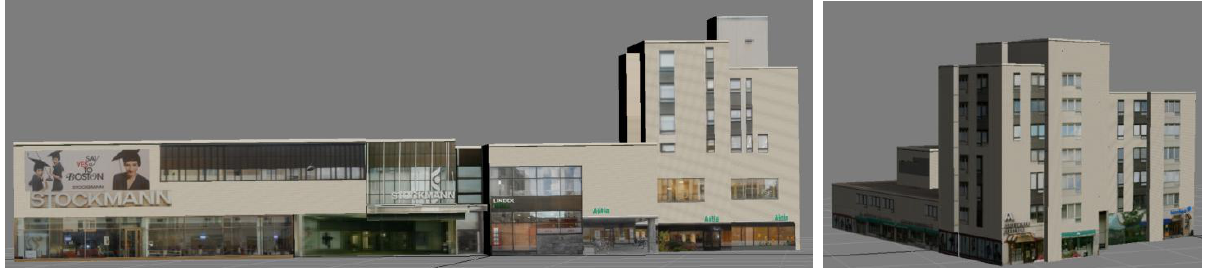
Figure 15. Models with textures provided via 3ds